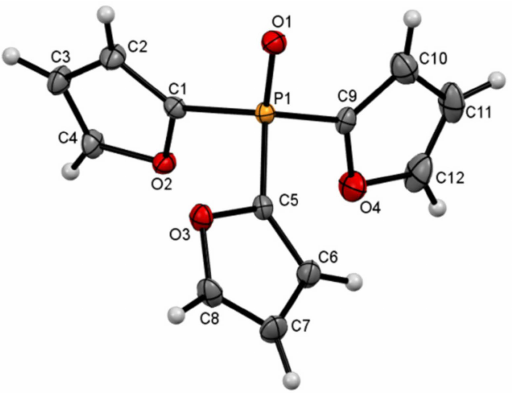
Figure 3. The crystal structure of tri-2-furylphosphinoxide 15